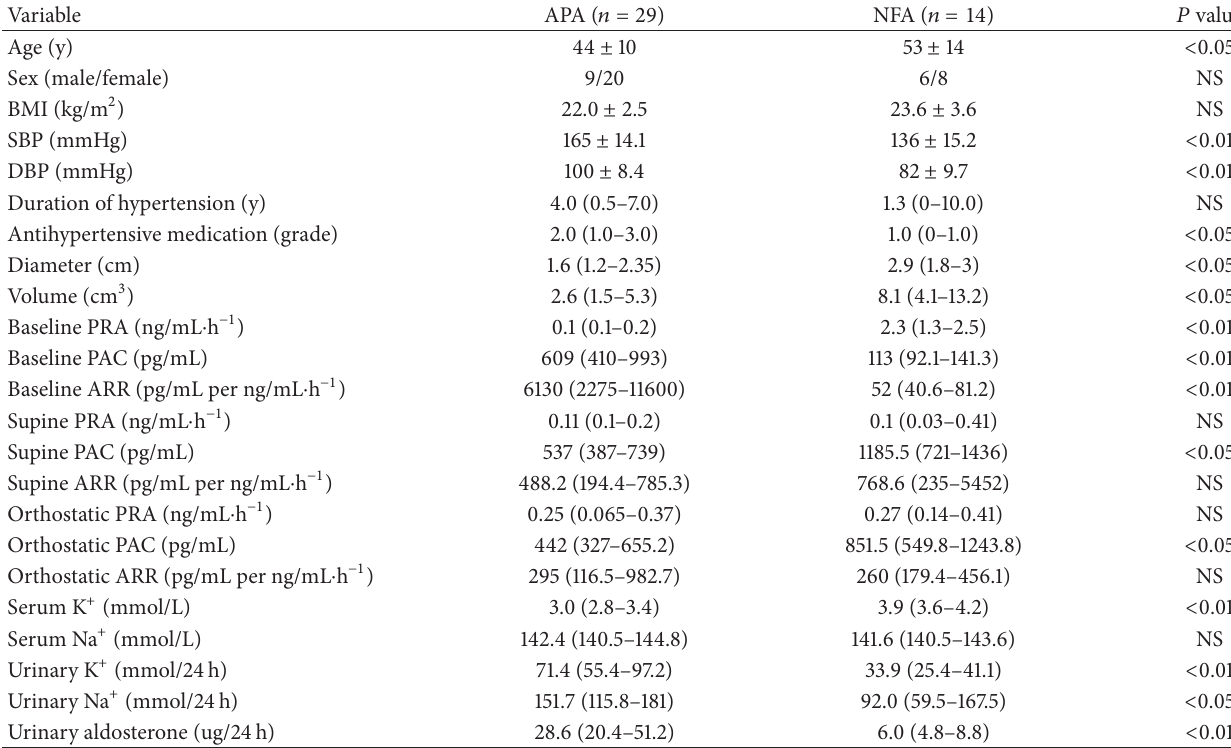
Table 1: Clinical and endocrinologic features of patients with APA and NFA in this